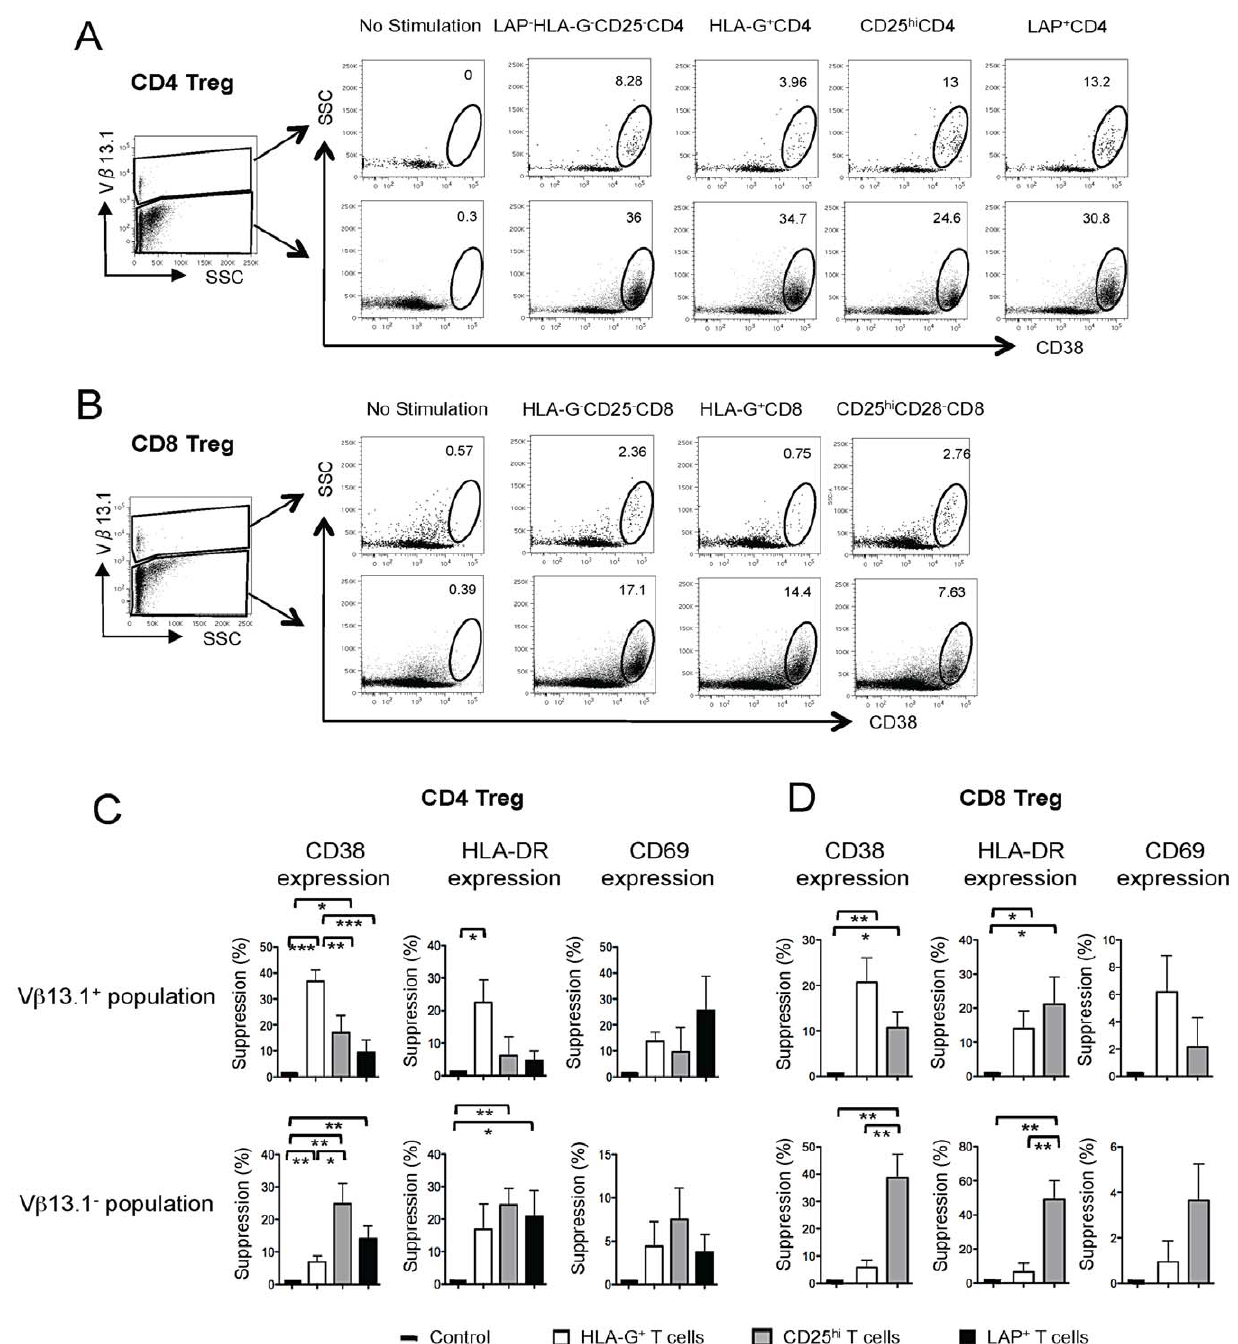
Figure 4. HLA-G + Treg reduce bystander activation of T cells. (A–B): Representative flow cytometry dot plots reflecting the surface expression of CD38 on V b 13.1 + and V b 13.1 2 responder T cells following exposure to indicated CD4 (A) or CD8 (B) Treg cell populations or negative control CD4 or CD8 T cells from HIV-seronegative donors. (C–D): Cumulative data representing relative suppression of CD38, HLA-DR and CD69 on V b 13.1 + and V b 13.1 2 responder T cells following exposure to indicated CD4 (C) or CD8 (D) Treg cell populations. Mean and standard deviation from n=8 HIV-1 negative study subjects are shown. Significance was tested by paired T test. doi:10.1371/journal.ppat.1003140.g004 limited effects on immune activation of V b 13.1-negative cells. This populations significantly affected CD69 expression on responder selective inhibitory effect on bystander activation was seen both for cells over the 4-day incubation period, likely because in comparison HLA-G + CD4 (Figure 4A/C) and CD8 (Figure 4B/D) T cells and to CD38, CD69 is only transiently upregulated for a short period substantially exceeded regulatory effects on bystander activation of after immune activation [26], and therefore could not be properly classical CD25 hi Treg or LAP + Treg. None of the tested Treg evaluated in our 4-day co-culture experiment.